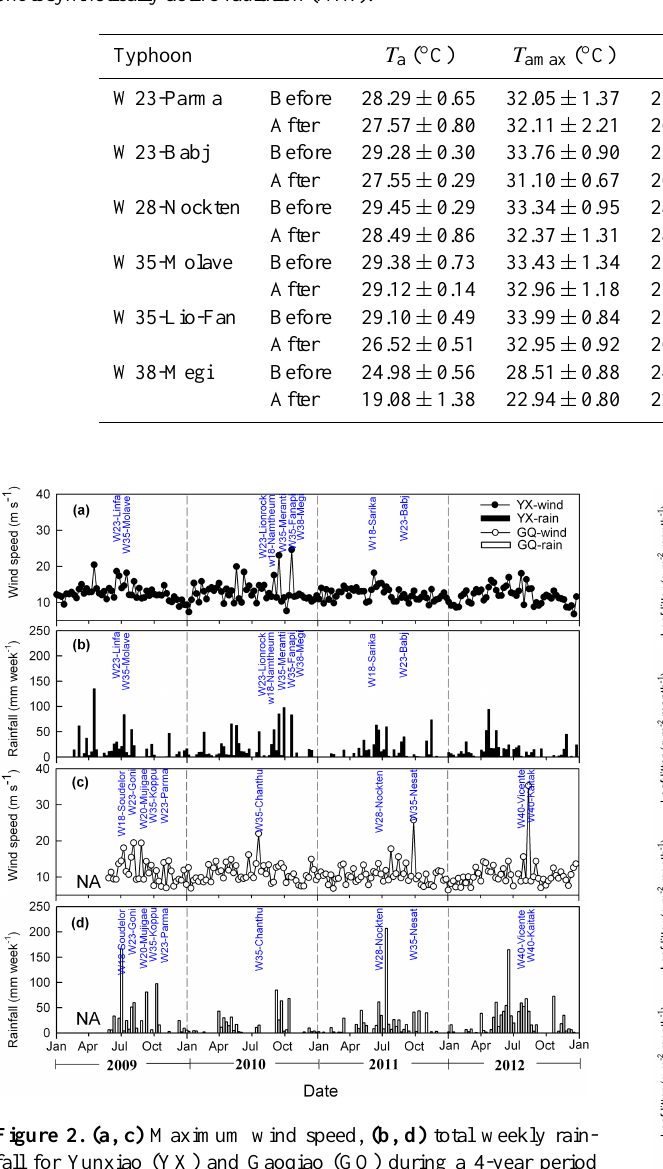
Table 1. Daily average microclimatic factors before and after typhoon made landfall for Yunxiao (YX) and Gaoqiao (GQ) in 2010, including daily means of air temperature ( T a ), maximum air temperature ( T amax ) , soil temperature ( T s ), maximum soil temperature ( T smax ) and total photosynthetically active radiation (PAR).